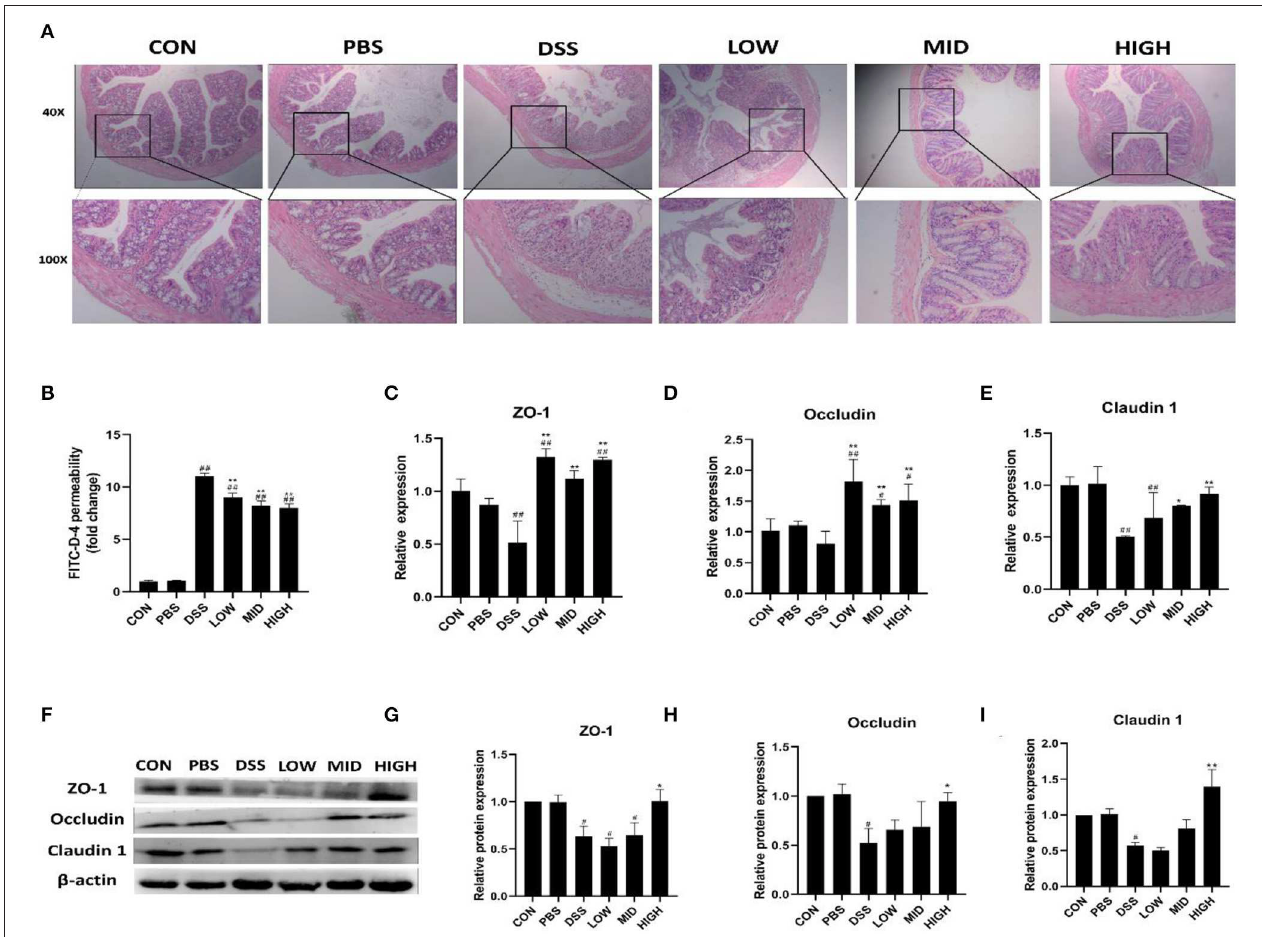
FIGURE 10 | The effect of BTL-1 on the intestinal injury of IBD mouse model induced by DSS. Histopathological changes after DSS stimulation in the colon (A) . The in vitro intestinal barrier function evaluated by FITC-D fluorescence intensity (B) . Upregulation of BTL-1 on tight junction proteins as determined by qPCR (C–E) and western blotting (F–I) . The results were expressed as the means ± SEM of n = 3. # P < 0.05, ## P < 0.01, compared to control group, * P < 0.05, ** P < 0.01 compared to DSS